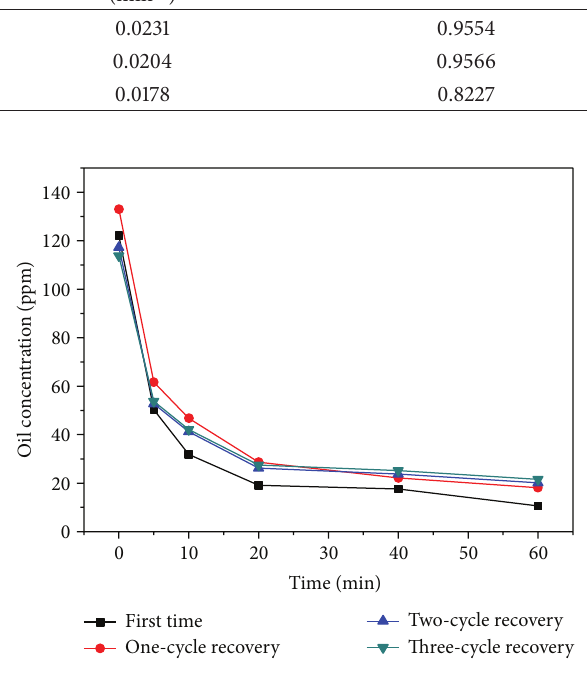
Figure 6: Photocatalytic performance of TSF after three